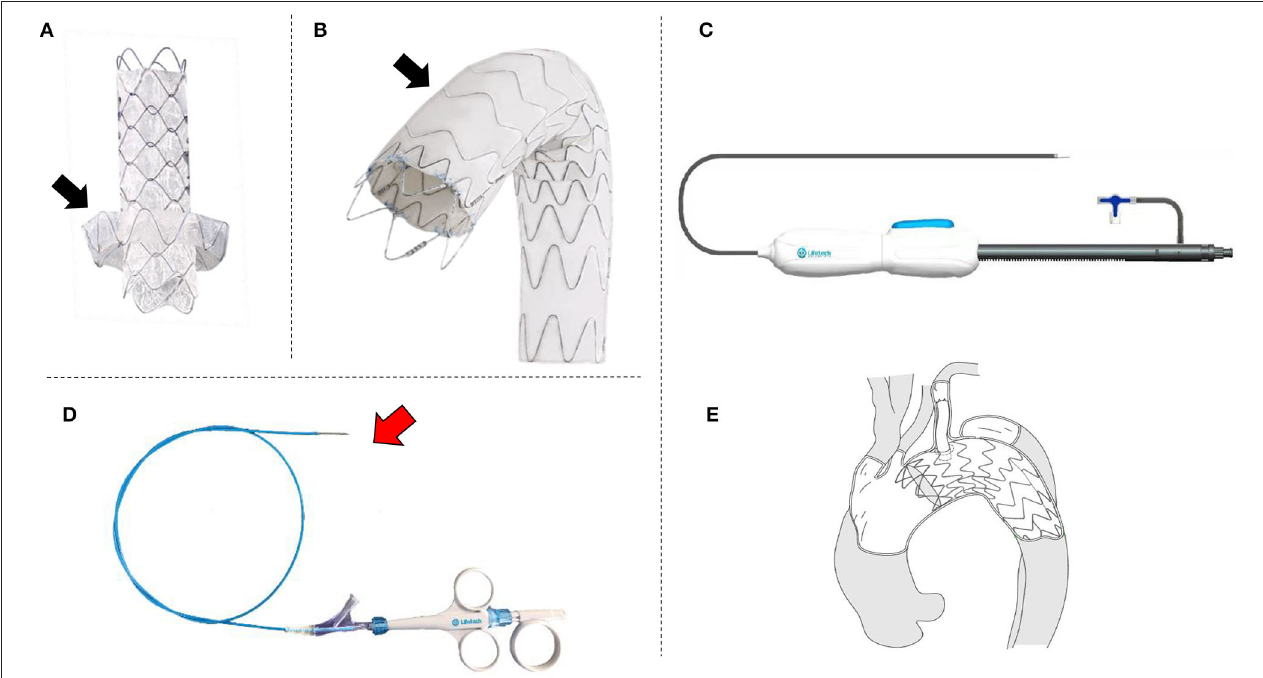
FIGURE 1 | The photos of and sketch of the novel device system. (A) Branch stent-graft with “skirt-like” structure to prevent endoleak (black arrow); (B) Aortic stent-graft special designed for in situ fenestration, the black arrow shows the area for fenestration; (C) Photo of a real product of the delivery system; (D) The puncture needle for the in situ fenestration, the red arrow shows the needle; (E) The sketch of the system which is after the in situ fenestration TEVAR by using the novel stent-grafts and puncture needle